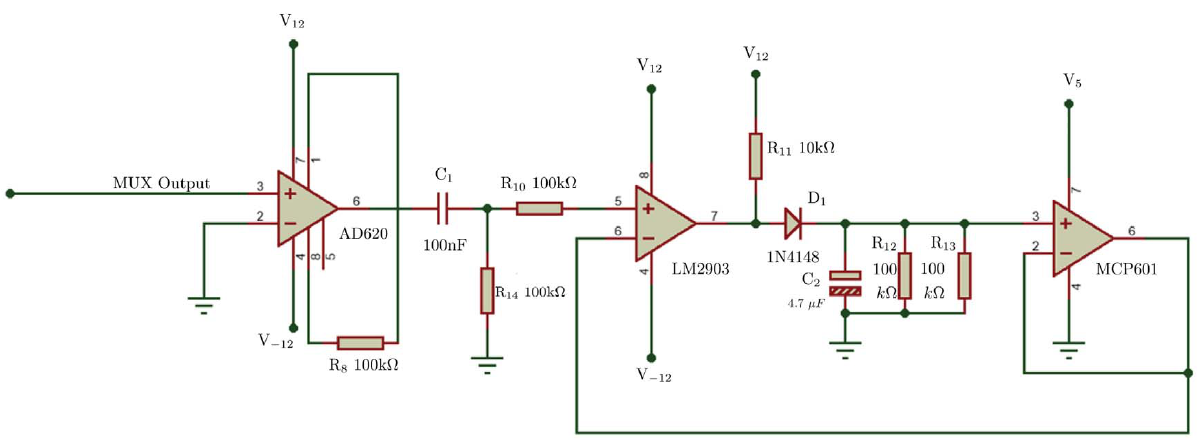
Figure 7. Proposed high-precision peak detector.